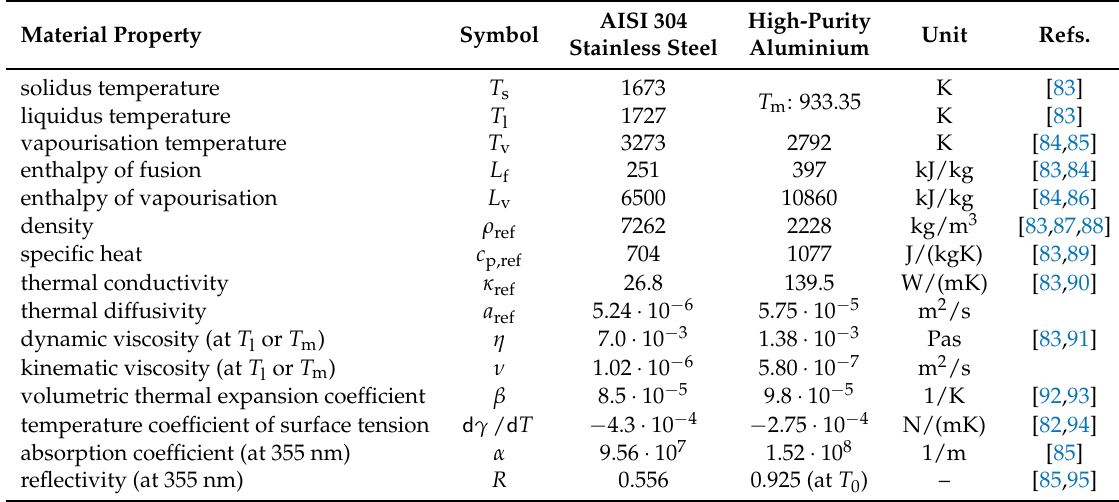
Table 3. Material properties of stainless steel and aluminium